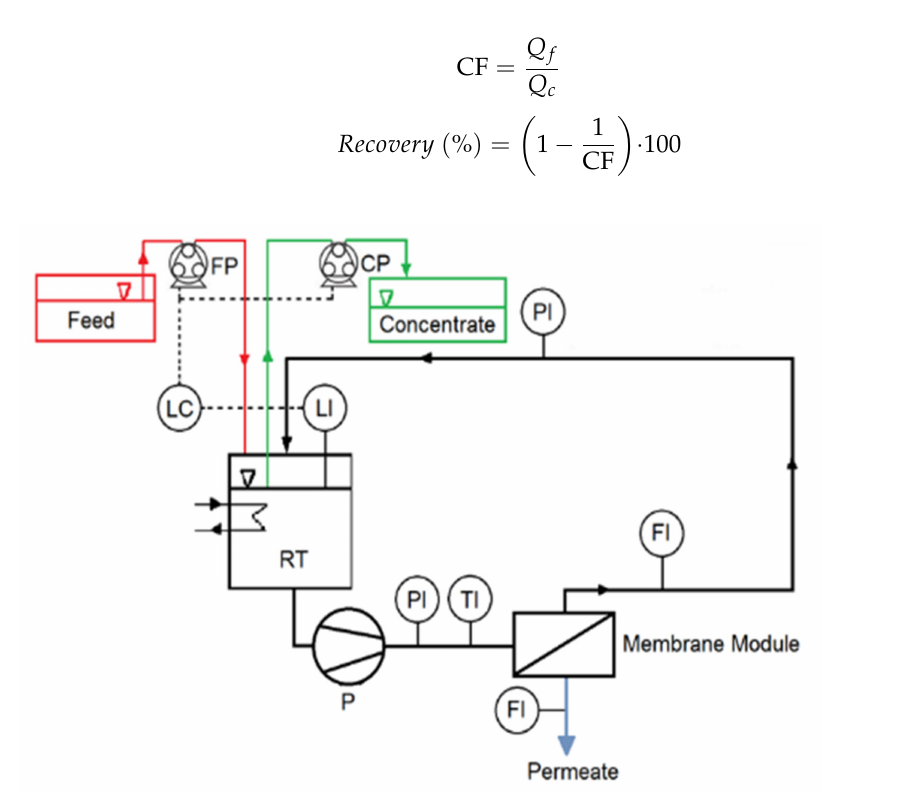
Figure 1. Schematic representation of the system. FP: Feed pump; CP: concentrate pump; RT: recirculation tank; P: pressure; T: temperature; F: flow; and L: